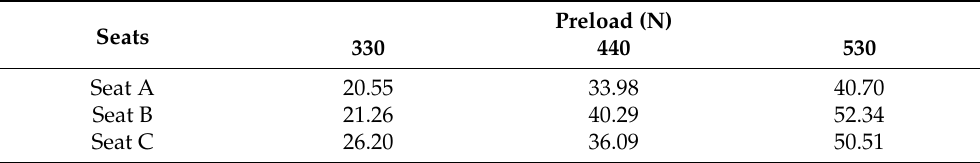
Table 2. Static stiffness (kN/m) of elastic seats under selected preloads.